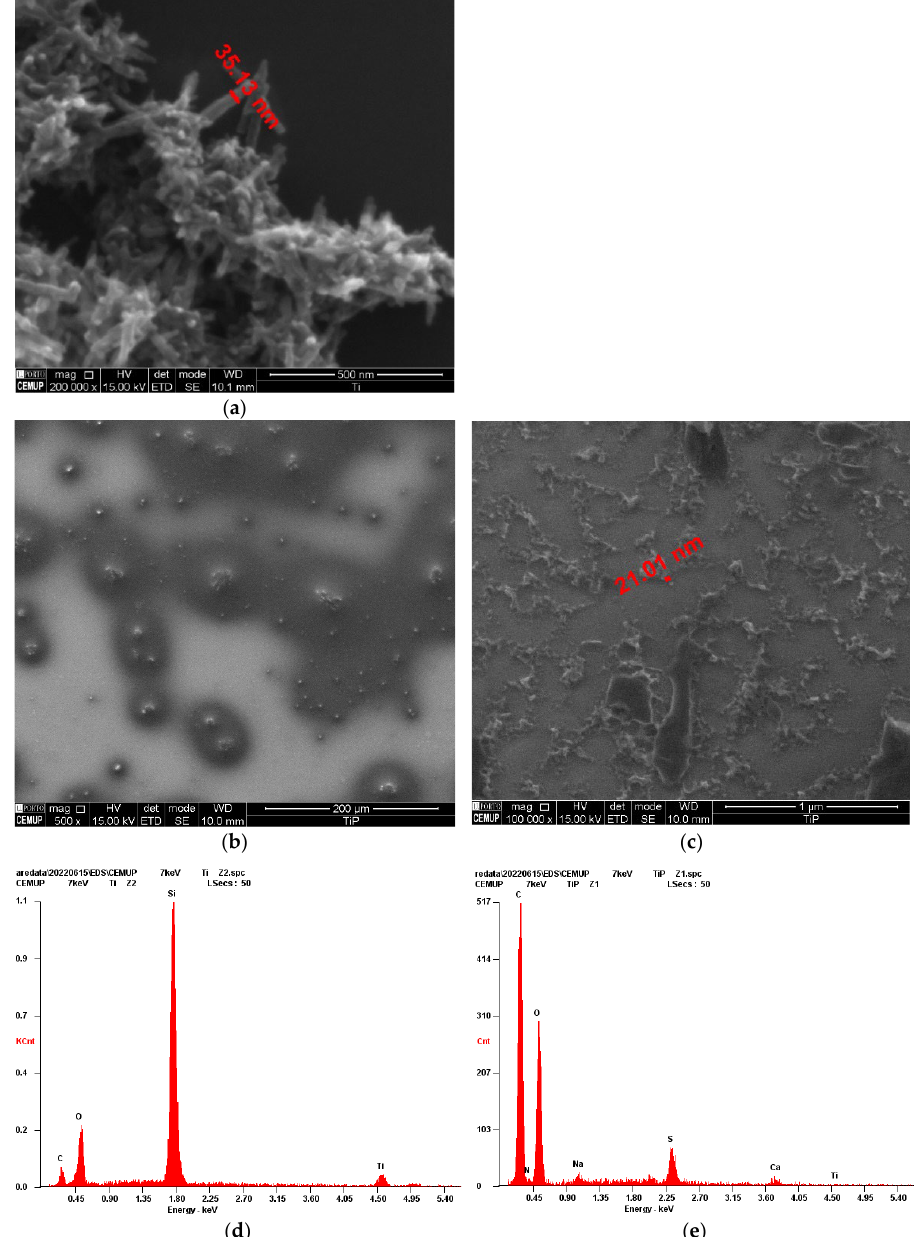
Figure 6. SEM images of the Ti-CD ( a ) and TiP-CD ( b , c ) samples and the corresponding EDS (Ti-CD ( d ) and TiP-CD ( e )).